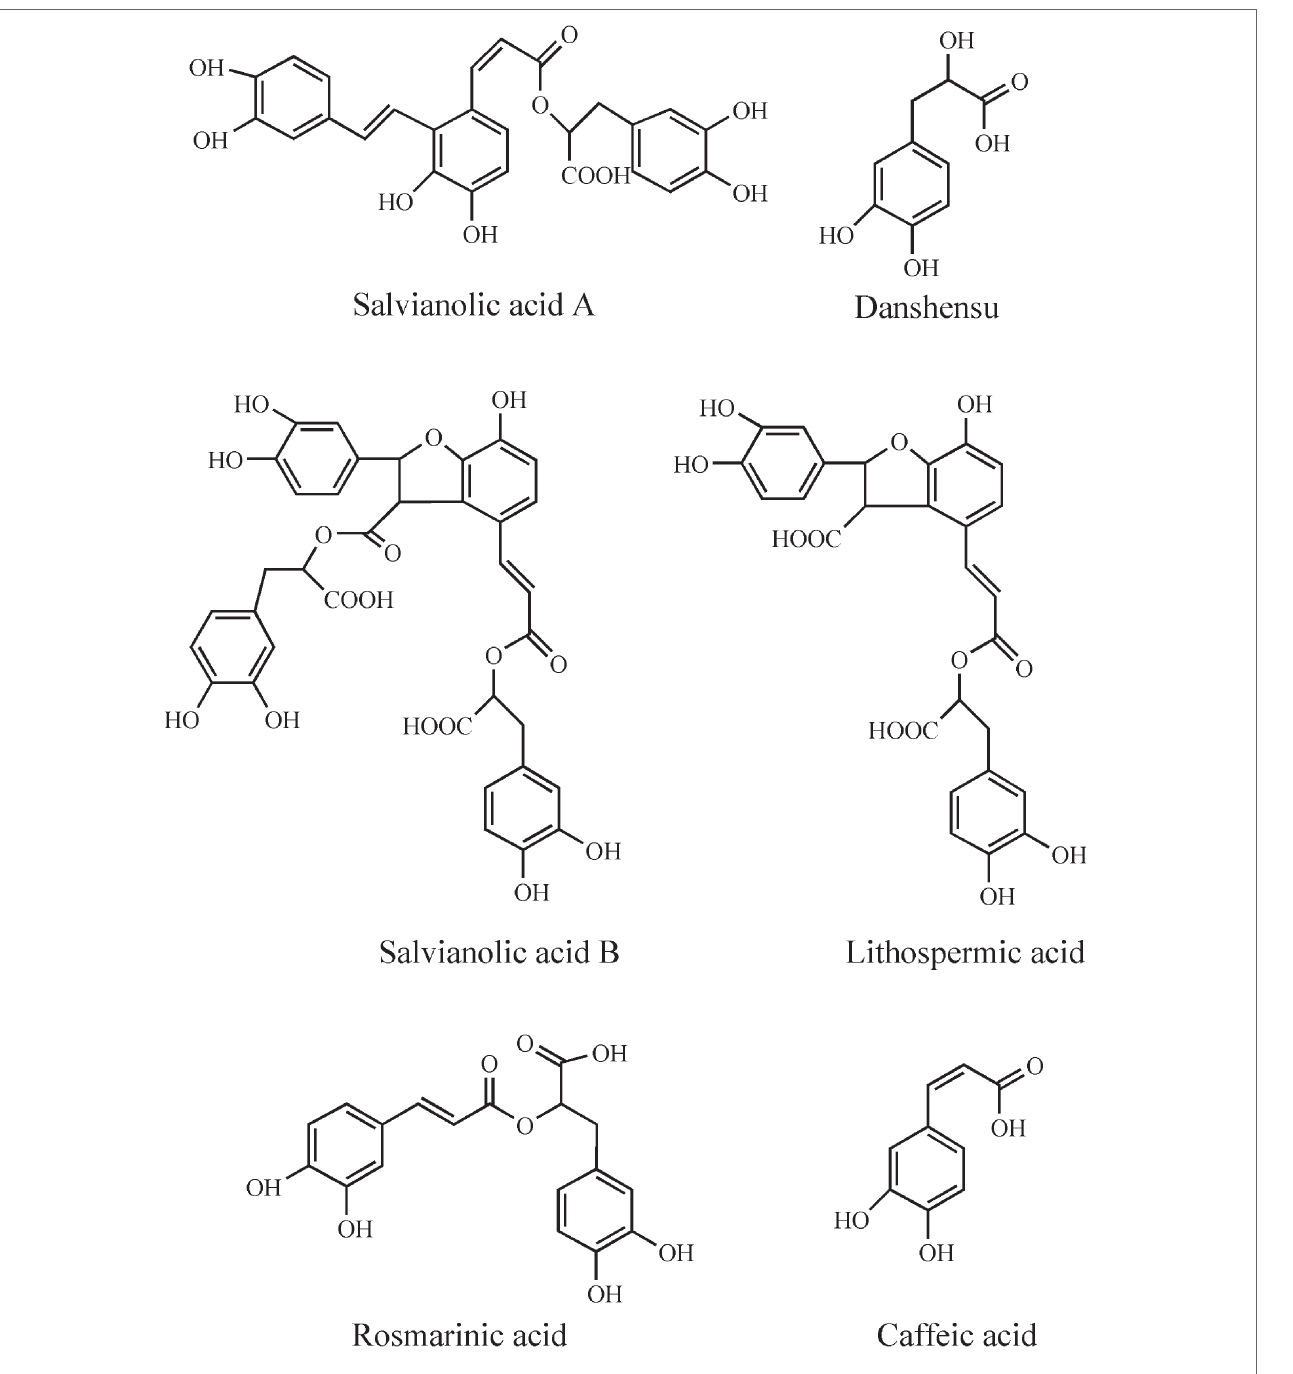
FIGURE 2 | Chemical structures of major salvianolic